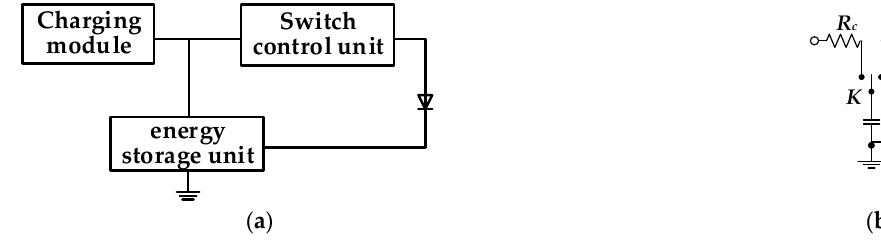
Figure 3. The equivalent circuit of a pulsed semiconductor laser driving module: ( a ) frame, ( b ) equivalent circuit.